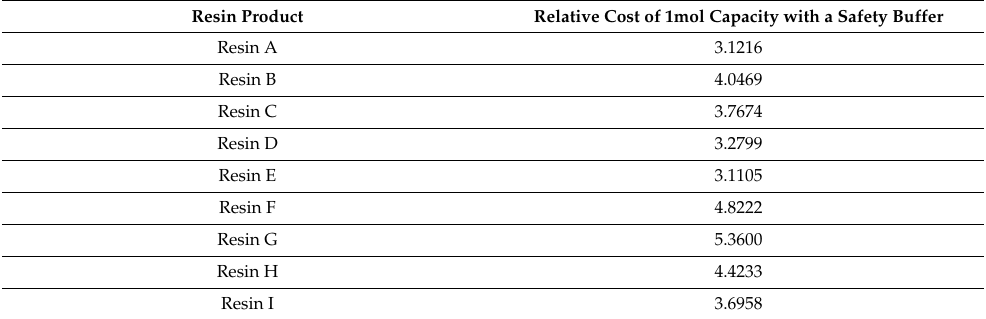
Table 4. The relative cost of 1 mol capacity for resin products corrected for a Six Sigma safety design buffer based on test standard deviation for applied